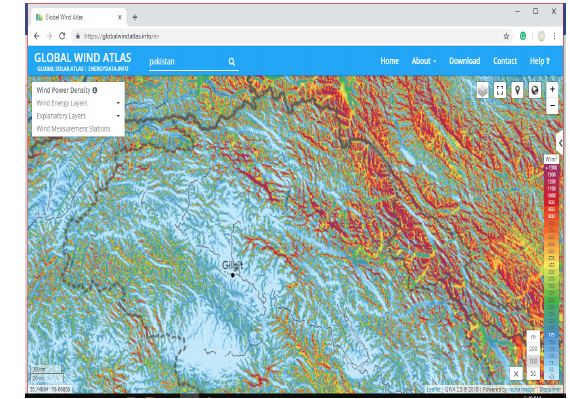
Fig. 1: Wind Atlas along the Northern Side of Pakistan